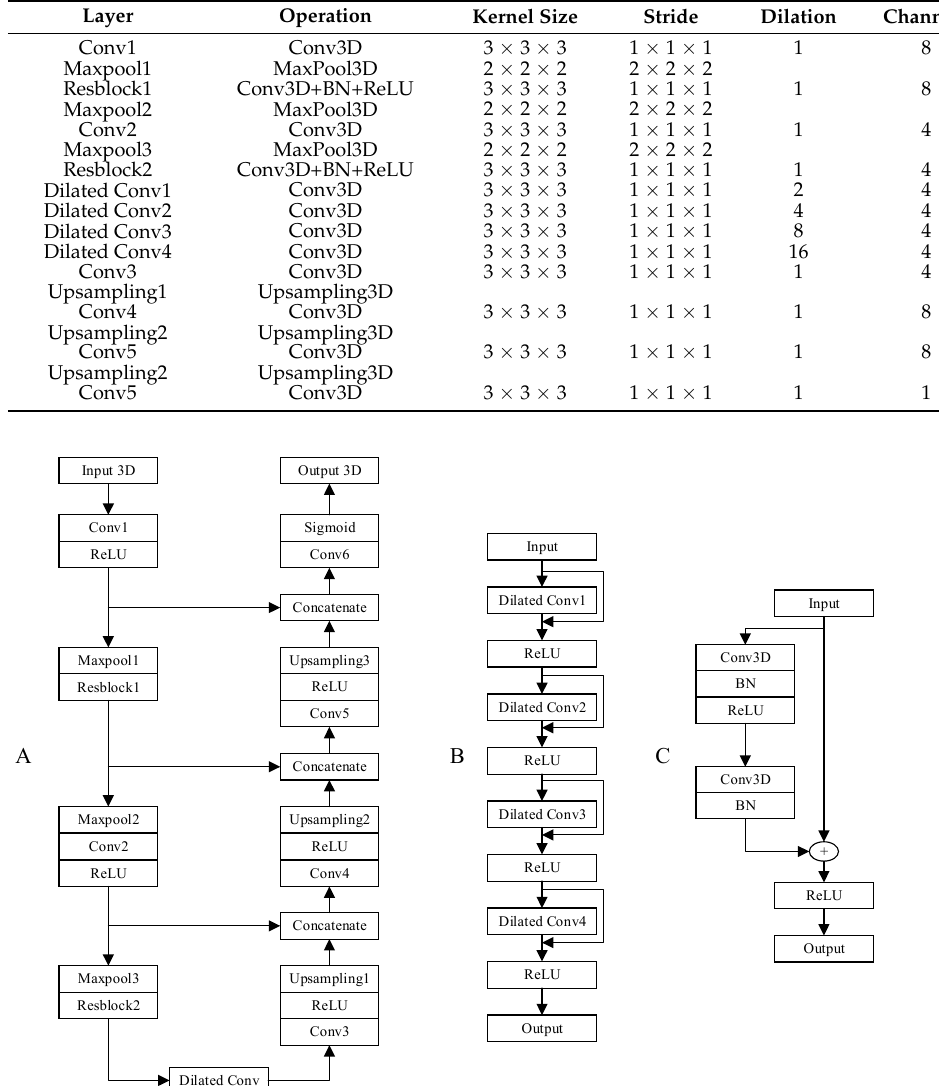
Figure 7. The overall structure of the 3D RDUnet network model. ( A ) The structure of the 3D RDUnet. ( B ) The structure of the dilated convolution layer. ( C ) The residual structure.